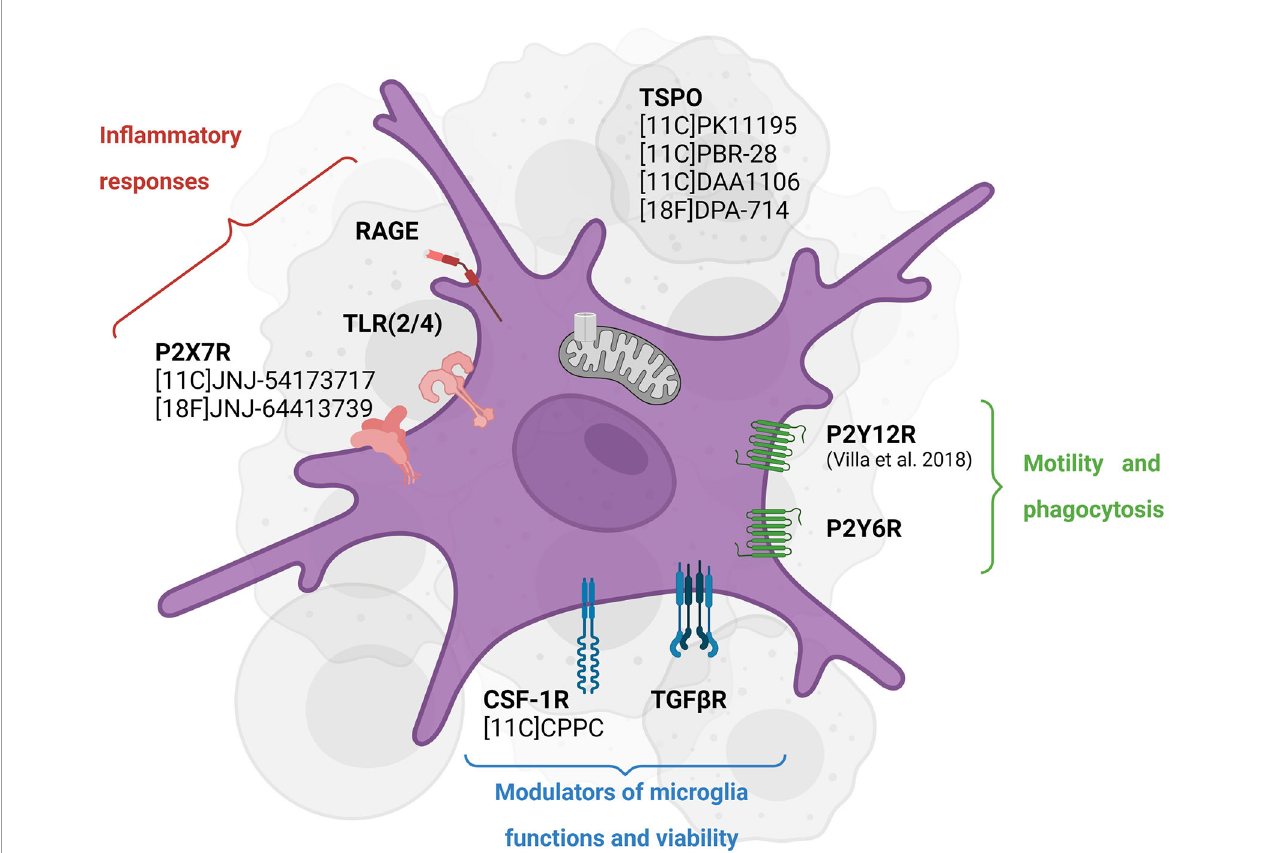
FIGURE 3 | Emerging targets for in vivo imaging of CSF-1R inhibition-induced microglial activity modulation. TSPO PET tracers have been widely used to assess neuroin fl ammation in different pathologies while they have shown some caveats, including inability to distinguish cellular sources of TSPO and phenotypes. Some of the newly investigated targets including P2X7R and P2Y12R highlight the different functions of microglial cells in an in fl ammatory environment. Created with